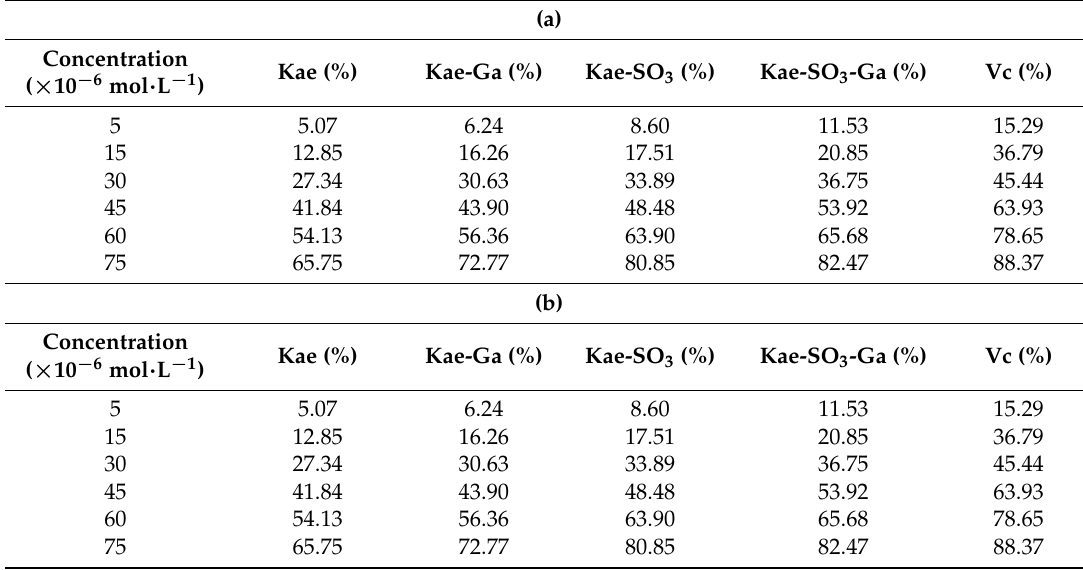
Table 6. ( a ) DPPH free radical scavenging ratio of different concentrations of Kae-based compounds. ( b ) ABTS free radical scavenging ratio of different concentrations of Kae-based